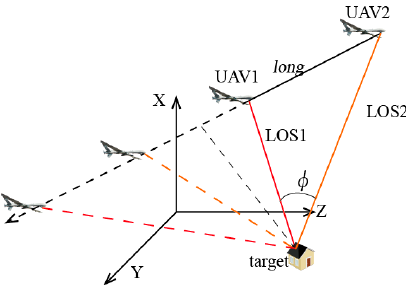
Figure 9. Positional relationship between the UAVs and the target.